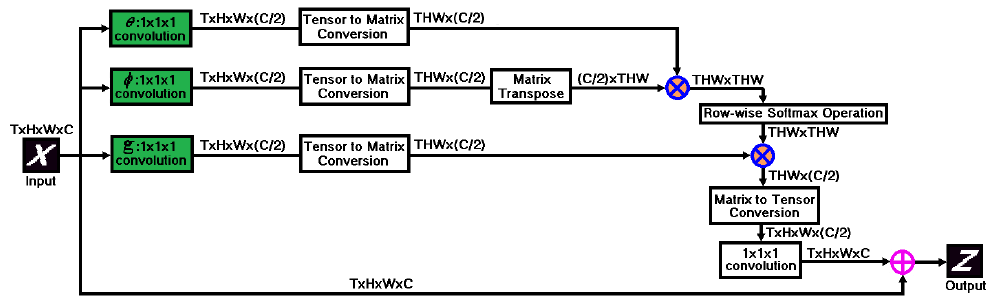
Figure 5. A space-time non-local